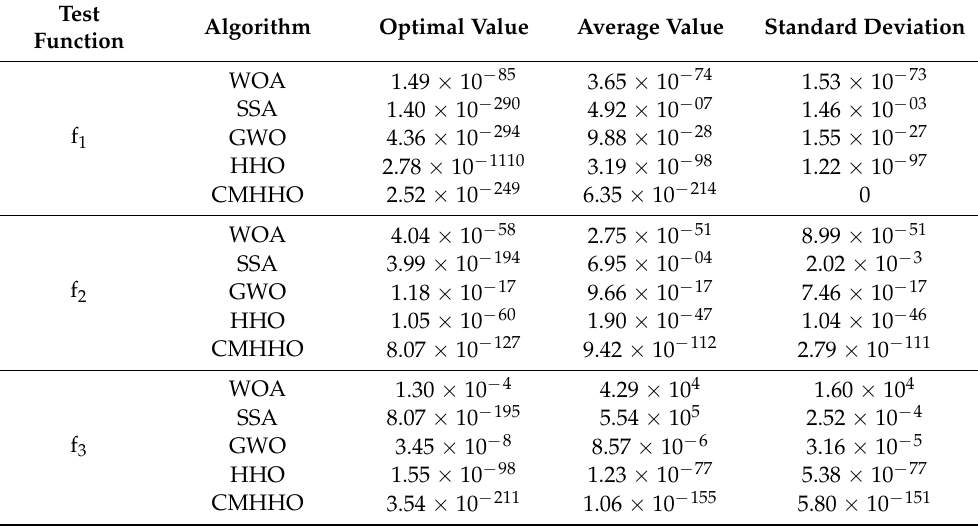
Table 2. Comparison of test results of different